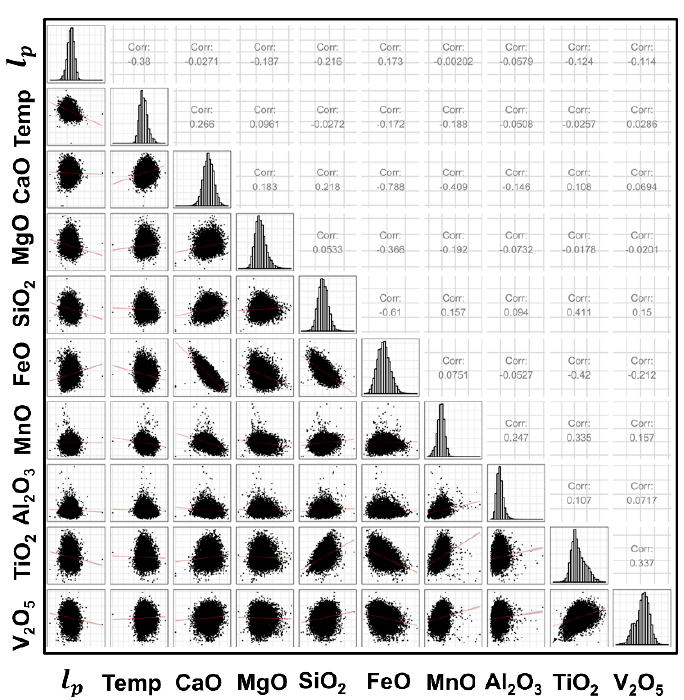
Figure 3. Scatter Plot Matrix representing linear relationships between variables from plant I. Table 2. Parameter Estimates, Standard Errors, T-values, and p-values of the regression parameter estimates. Plant